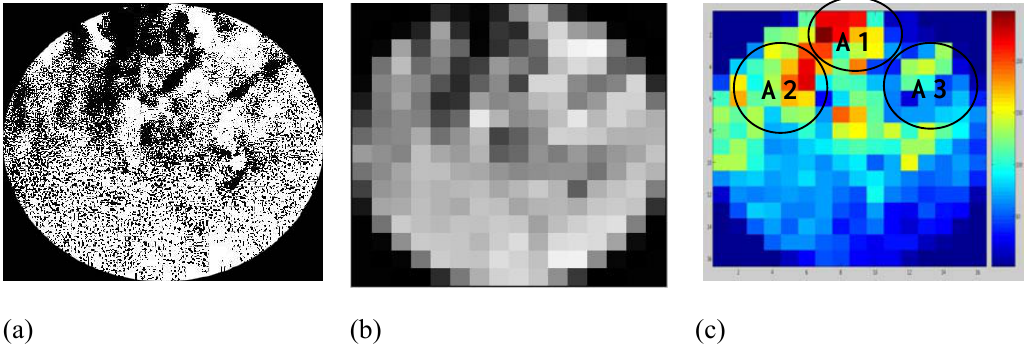
Figure 14. Image recorded by CCD Camera (a) Real Image Captured (b) Real image resized to 16 × 16 pixels with grey color (c) Real image resized to 16 × 16 pixels with color